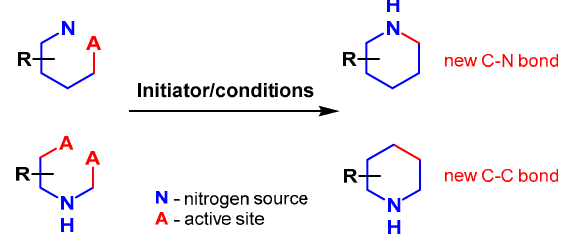
Scheme 13. Main scheme of intramolecular cyclization.